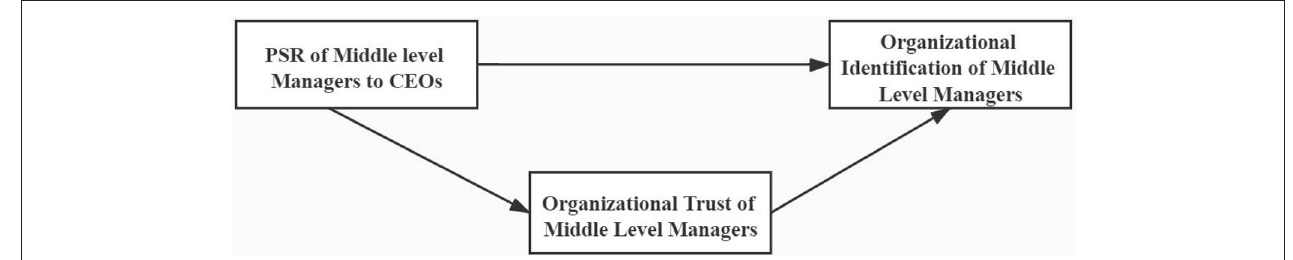
FIGURE 2 | Conceptual